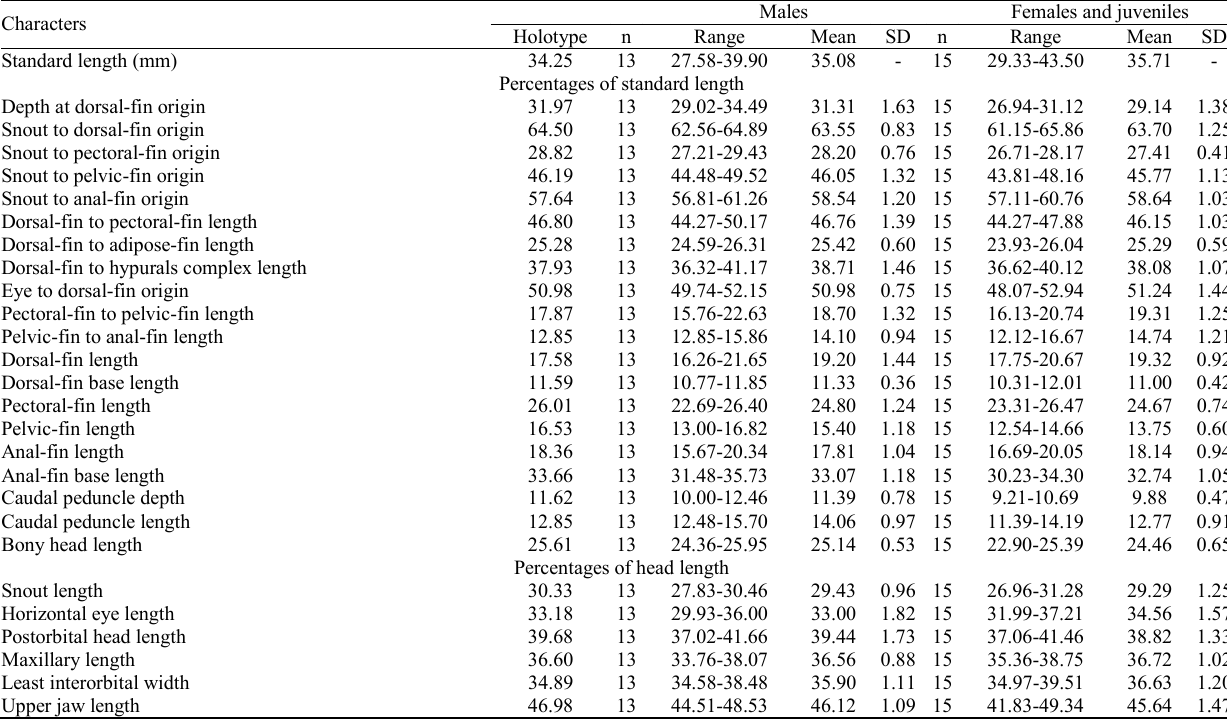
Table 1. Morphometric data of holotype and 27 paratypes of Chrysobrycon eliasi from río Madre de Dios and Upper río Manuripe basins. n = number of specimens; SD = standard deviation. The values of the holotype are included in the range of